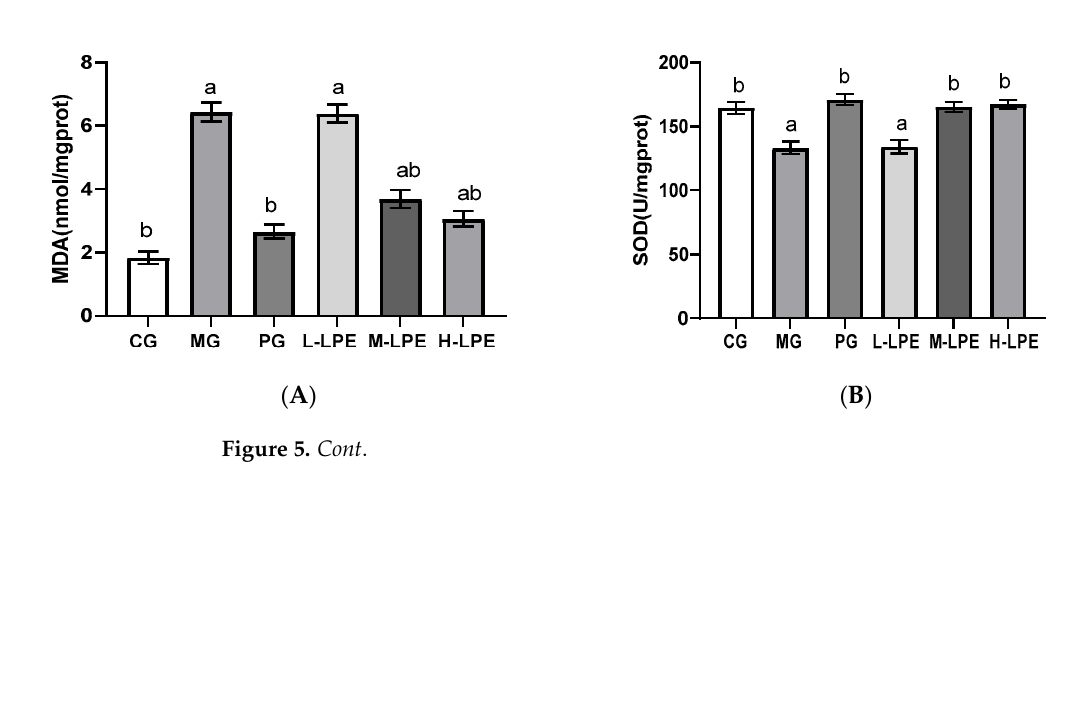
( D ) Figure 5. MDA, SOD, GSH, and protein carbonyls levels in the kidney of mice: ( A ) MDA contents in the kidney of mice; ( B ) SOD activity in the kidney of mice; ( C ) GSH contents in the kidney of mice; ( D ) protein carbonyls content in the kidney of mice. Values are expressed as mean ± standard error ( n = 12 in each group). Values with different superscripts showed a difference with statistical significance, p < 0.05, “a” as a statistical difference compared with the blank control group, “b” as a statistical difference compared with the model group. 4. Discussion The Litchi pericarp contain numerous health-enhancing components with great po- tential application in the food industries. Therefore, the utilization of valuable ingredients from litchi processing by-products in food additives is a very important area for research- ers. The quantification of these active ingredients in relation to the physiological functions of Litchi pericarp needs to further be studied. Additionally, the development of efficient, safe, and convenient extraction methods should be considered. Polyphenol content in extracts is related to their antioxidant function. The recovery of the polyphenol compounds from natural plant sources could increase their commercial value. Thus, it is very important to optimize the extraction process conditions to obtain a high extraction rate for polyphenols. In general, drying of the sample was required till extraction, but drying remarkably impacted the bioactive activity and the phytochemical compositions. An existing study showed how different drying treatments affected poly- phenols in the pericarp of three longan cultivars, finding that the content of polyphenols followed an increasing order for the drying methods as follows: solar radiation < micro- wave radiation < lyophilization [22]. The previous study further showed that there was no difference in the content of polyphenols between the lyophilized pericarp and fresh pericarp [22]. This study used lyophilized fresh litchi pericarp for extraction. In this study, the extraction rate for LPE was approximately 4.76% in fresh litchi pericarp, and the con- tent of total polyphenol was approximately 750.6 mg GAE/g LPE. Previous work revealed